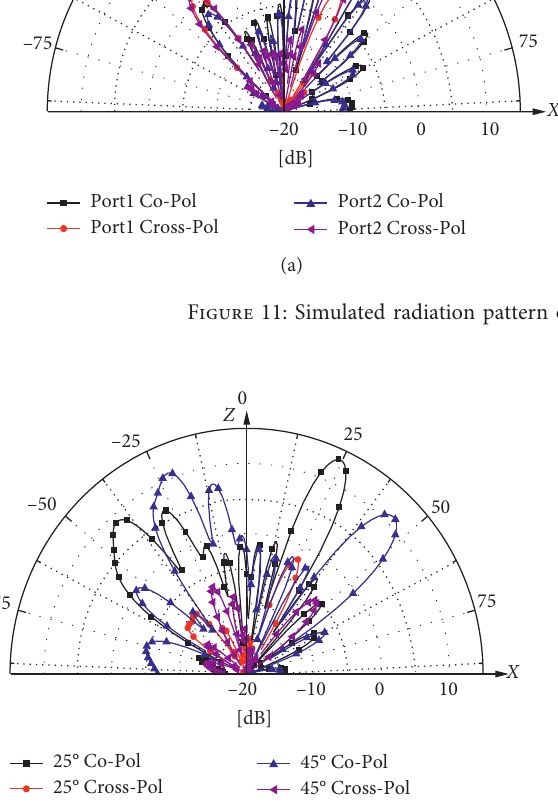
Figure 12: Simulated radiation pattern of the array (b), Port 1.